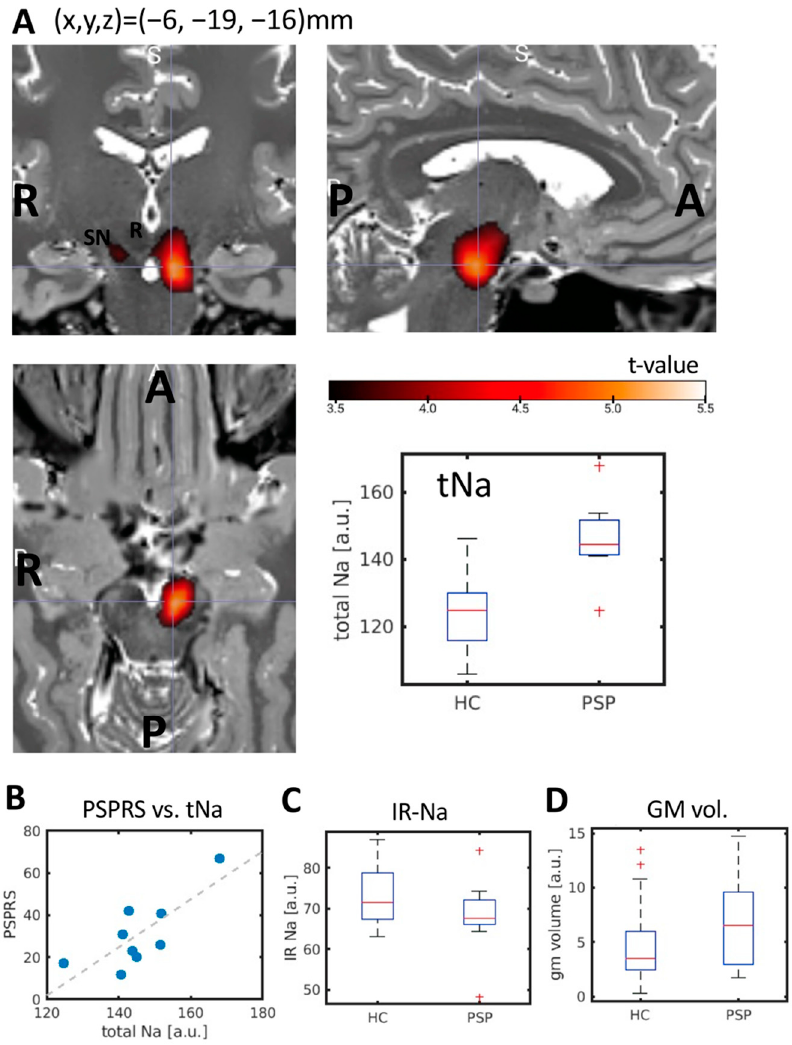
Figure 1. ( A ) Increased midbrain total sodium in PSP patients compared to healthy controls (0.05 FWE-corrected; significant cluster indicated by the crosshairs). ( B ) The total sodium was correlated to symptom severity as measured by the PSPRS (Pearson’s rho = 0.778; p = 0.014). We did not find evidence for significant between-group differences in ( C ) intracellular weighted sodium (IR-Na) nor ( D ) gray matter volume. a.u.: arbitrary units. GM: gray matter. HC: healthy controls. IR-Na: intracellular-weighted (inversion recovery) 23 Na-MRI. PSP: progressive supranuclear palsy. PSPRS: PSP rating scale. R: red nucleus. SN: substantia nigra. tNa: total sodium weighted 23